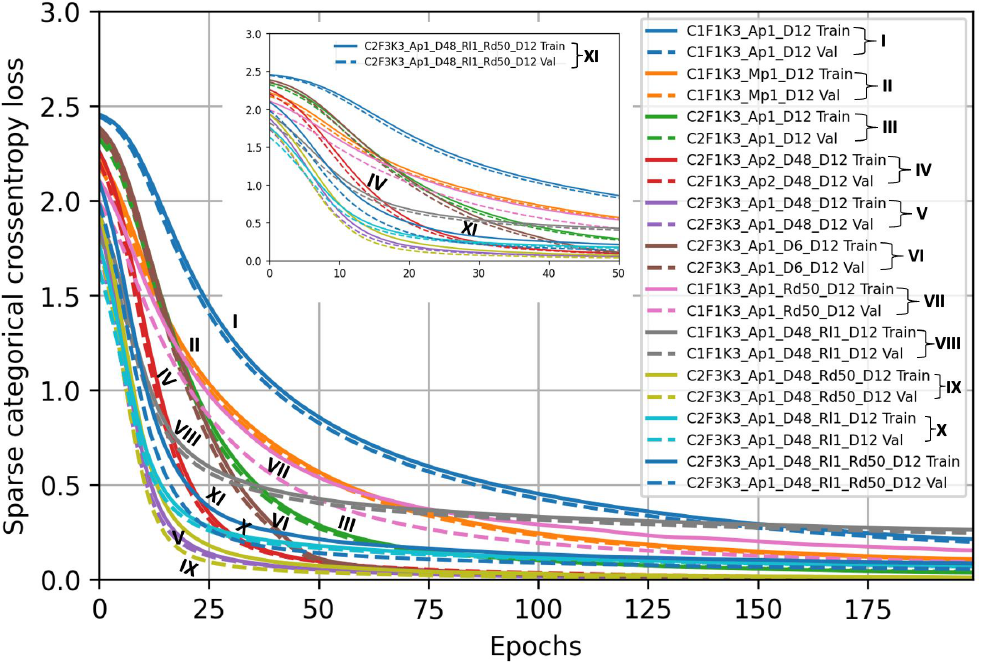
Figure 4. Loss on training and validation data for the considered CNN model